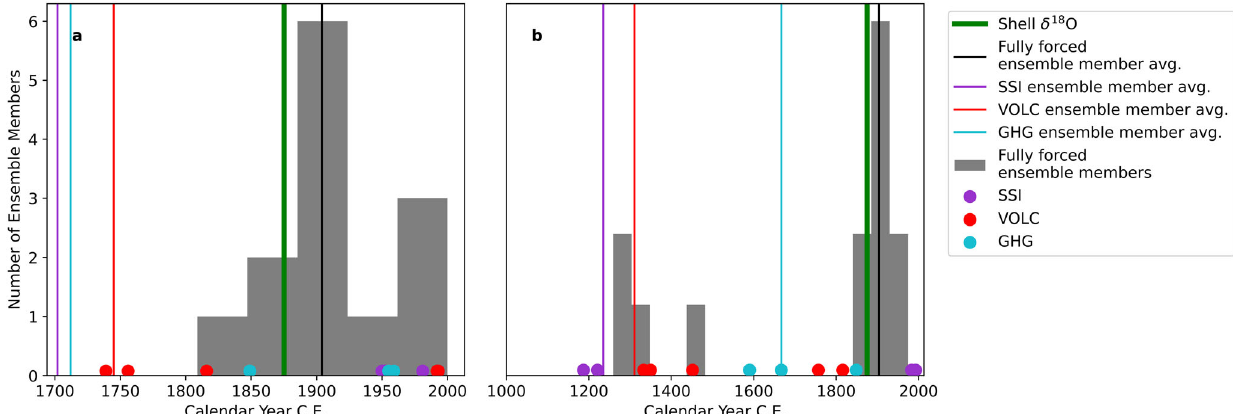
Fig. 4 Distribution of breakpoints of Gulf of Maine temperature and oxygen isotope time series. a Breakpoint years calculated from segmented regression analysis of single and fully forced simulations as well as the oxygen isotope record over the period of overlap between the records (1694 – 2005). The histogram plots the breakpoint year of ensemble members of the fully-forced simulations, with a bin-size of ~60 years. The oxygen isotope record breakpoint (green vertical line) is 1875 and calculated over the full record (1694 – 2013). The calculated breakpoint for each single forced ensemble member are represented by colored points on the x -axis.Years of ensemble member mean breakpoints (for both full forcing and single forcing simulations) are represented as vertical lines. b As in a but segmented regression analysis is performed over the entire millennium period (1000 – 2005). Bin size is still ~60 years. Oxygen isotope breakpoint included for reference. SSI spectral solar irradiance, VOLC volcanic, GHG greenhouse gas. Breakpoint years calculated from the climate model simulations are the result of segmented regression analysis of annual temperatures at 35 m depth in the Gulf of Maine for individual ensemble members (colored points; both full forcing and single forcing), the ensemble member mean (vertical lines; both full forcing and single